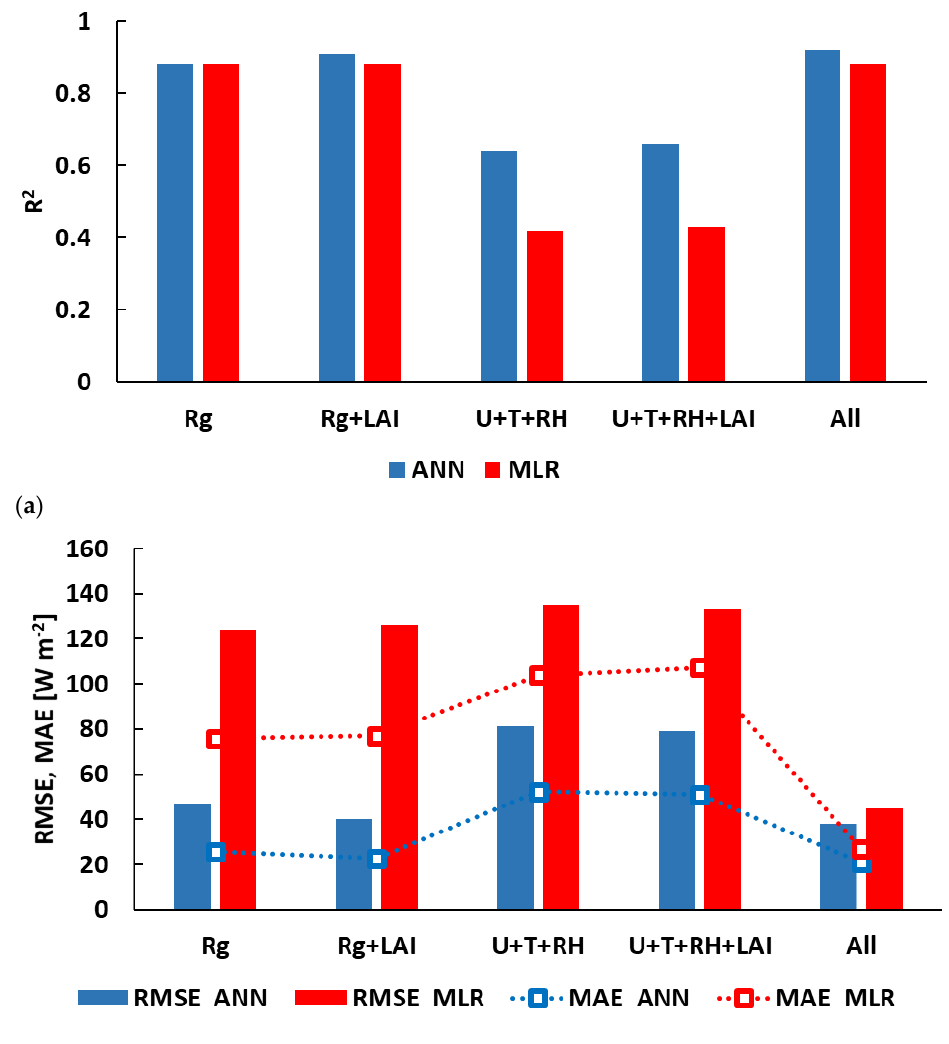
Figure 6. Regression results for ANN and MLR models derived based on different input variables (in the X-axis). “All” indicates that all input variables were used to derive the model. ( a ) R 2 ; ( b ) RMSE and MAE (W m −2 ). Legend: R 2 — bars, RMSE — bars, MAE — square symbols. ANN — blue; MLR — red.